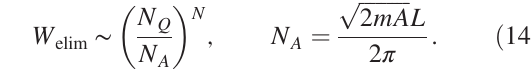
’ sof Q ð 8 Þ forthe 2 m ,